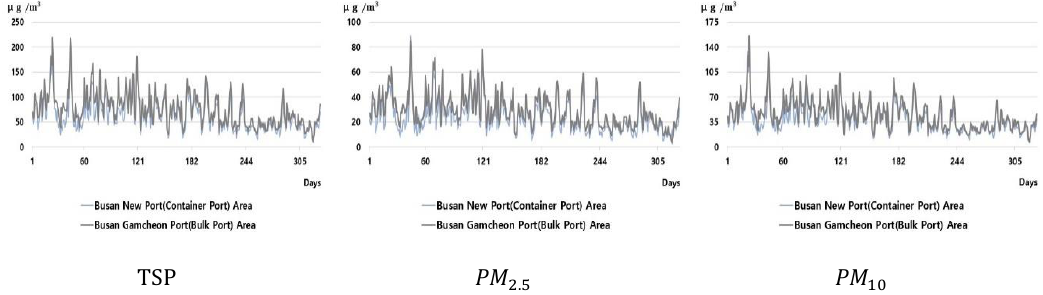
Figure 5. Comparison of PM Concentrations between Busan New Port and Gamcheon Port.